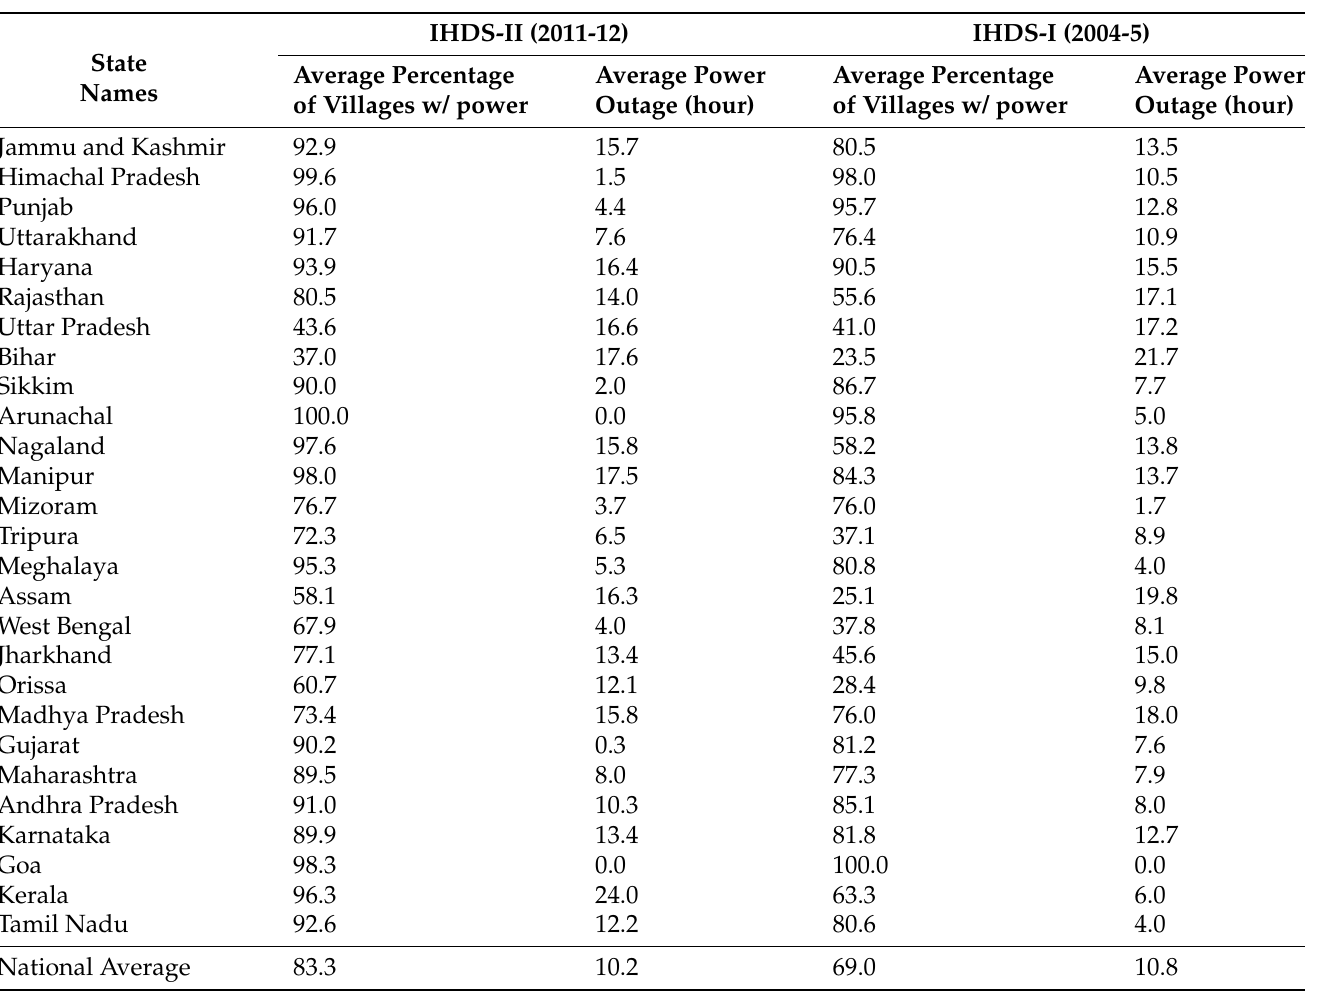
Table 1. Average percentage of villages with power and the average power outage in hours for each state. IHDS, India Human Development